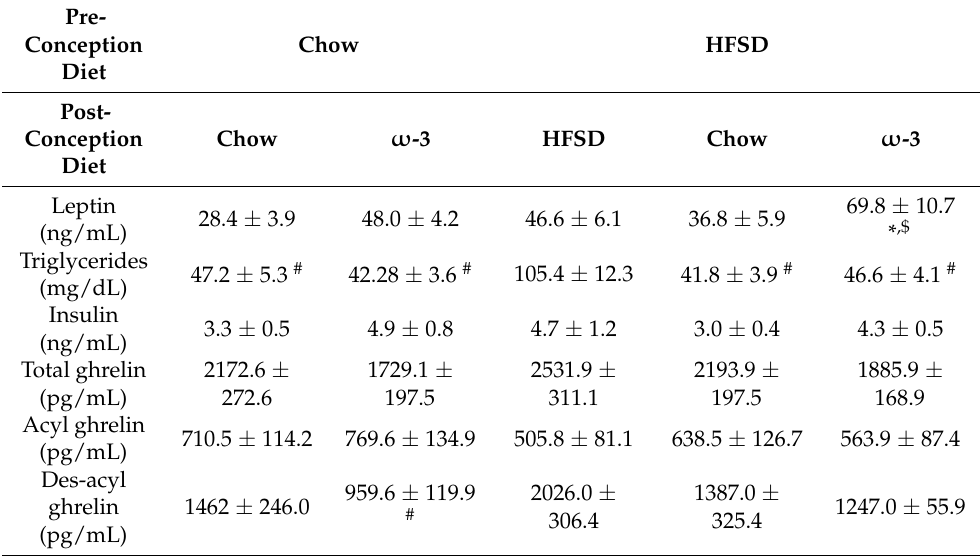
Table 3. Maternal metabolic